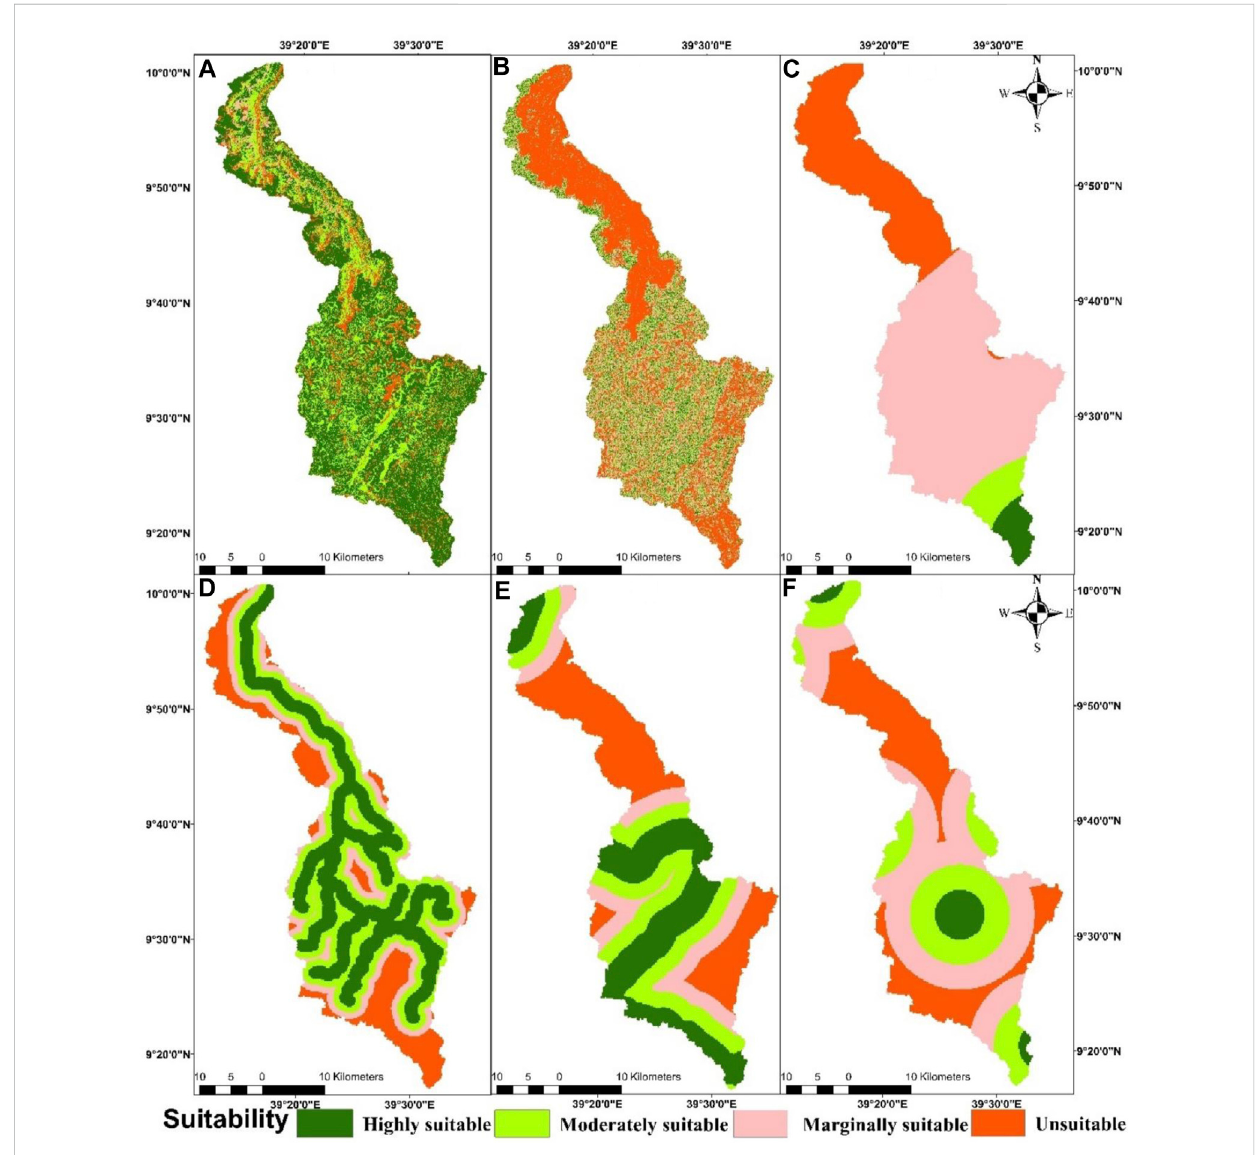
FIGURE 5 Surfaceirrigationsuitabilitydeterminedbasedonvariousfactors,including: (A) Landuselandcover(LULC); (B) Slope; (C) Rainfall; (D) Riverproximity; (E) Road proximity; and (F) Market/town